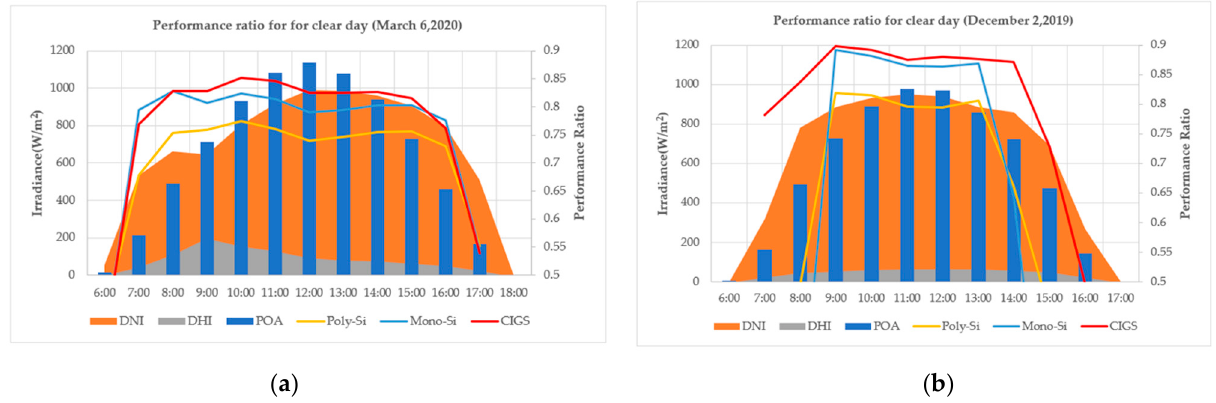
Figure 6. Cloud cover vs. performance ratio.